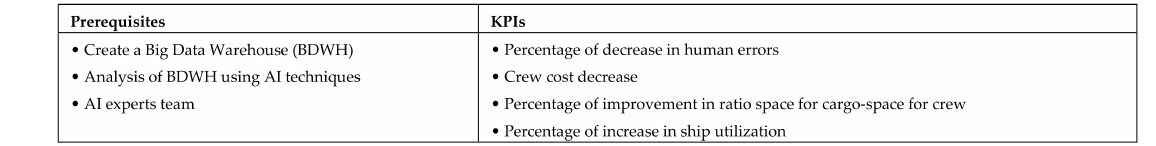
Figure A11. Route optimization via AI analysis of operational information data sheet.